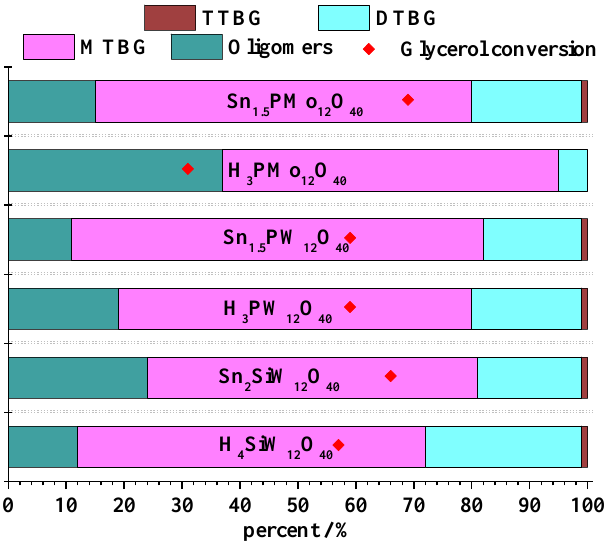
Figure 22. Conversion and selectivity of glycerol etherification reactions in the presence of Keggin heteropolyacids or their Sn 2+ salts (adapted from ref. [64]).